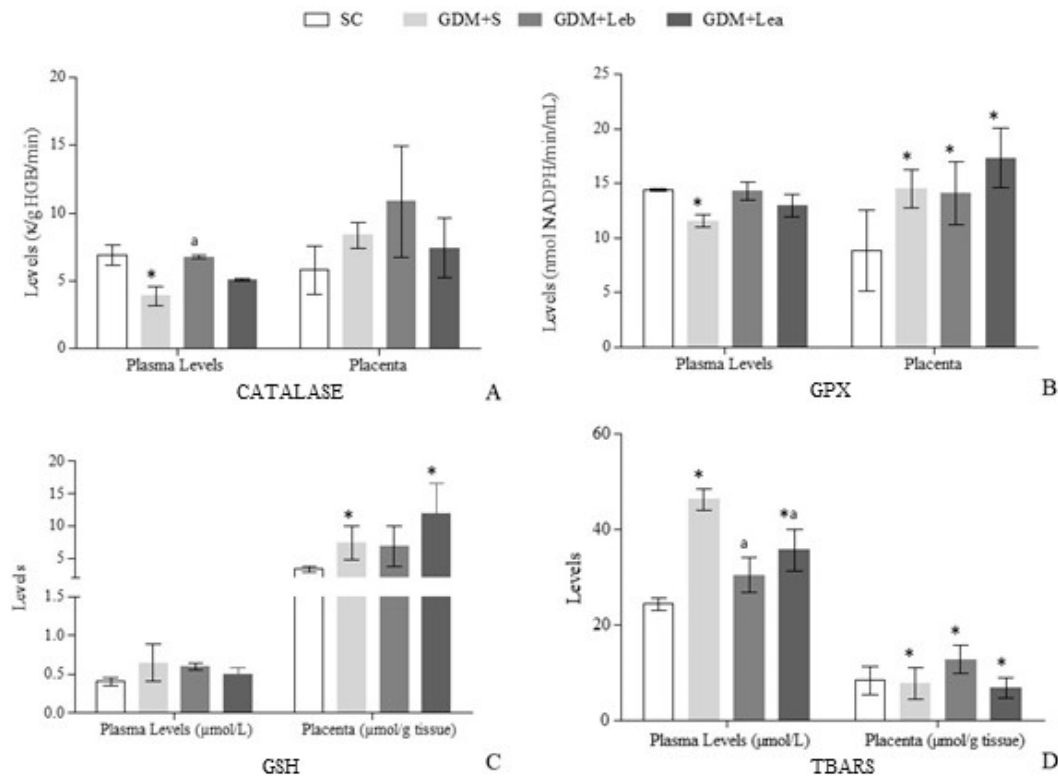
Figure 4. Activity level of catalase, reduced glutathione (GSH), glutathione peroxidase (GPx) and thiobarbituric acid reactive substances (TBARS) in blood and placenta of pregnant rats. ( A ) Catalase activity in total blood and placenta. ( B ) GPx activity in total blood and placenta. ( C ) GSH concentration in total blood and placenta. ( D ) TBARS concentration in plasma and placenta. SC (saline control 0.9%), GDM + S (diabetic + saline solution 0.9%), GDM + Leb (diabetic + 100 mg/kg/day of Lentinus edodes before fetus implantation) and GDM + Lea (diabetic + 100 mg/kg/day of Lentinus edodes after fetus implantation). Data are presented as mean ± SD or percentage. * p < 0.05 in comparison to SC group, a in comparison to GDM + S group, one-way ANOVA, followed by Tukey–Kramer’s.